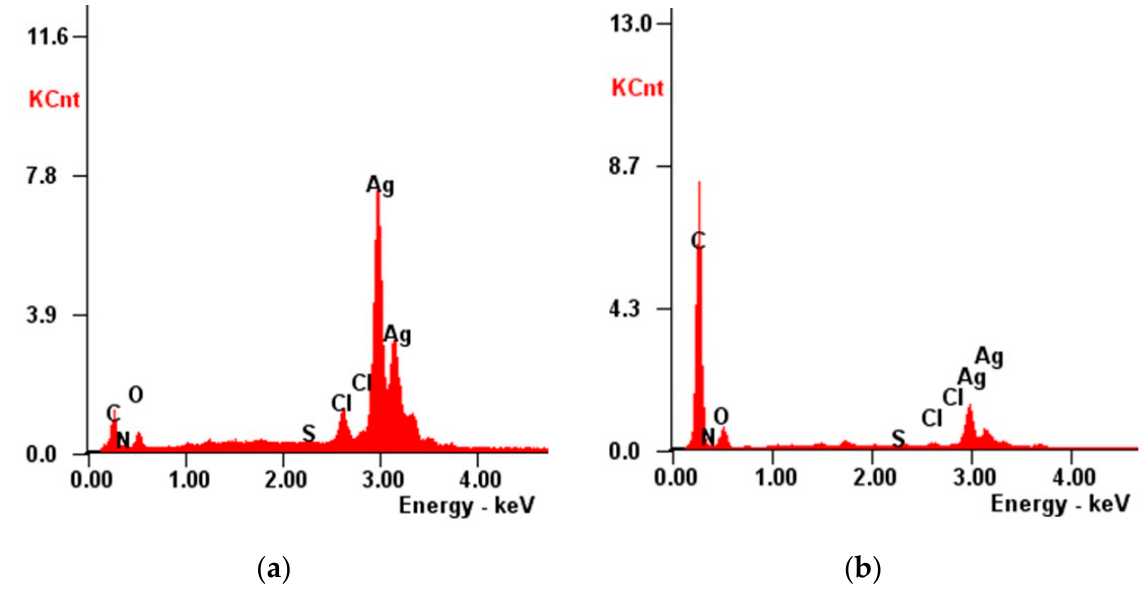
Figure 13. EDX spectra of AgNPs-H 2 O ( a ) and of AgNPs-EtOH ( b ) .